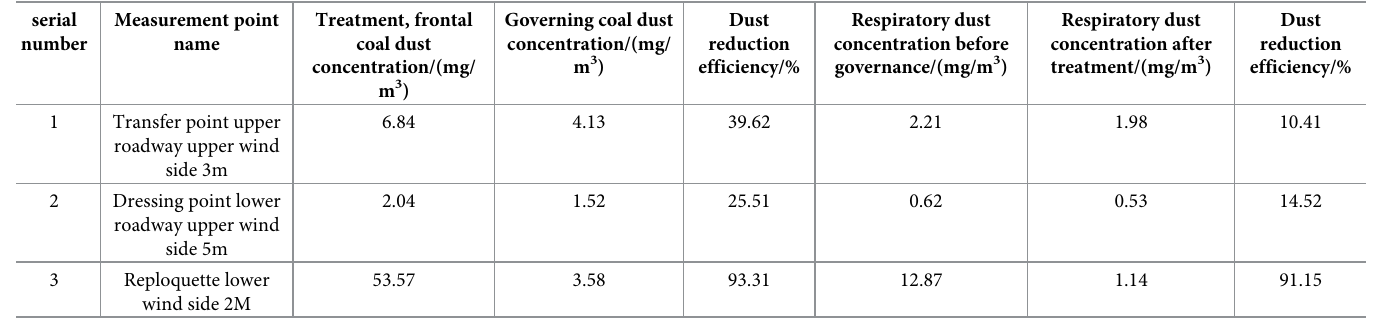
Table 2. Contrast of respiratory coal dust concentration before and after comprehensively